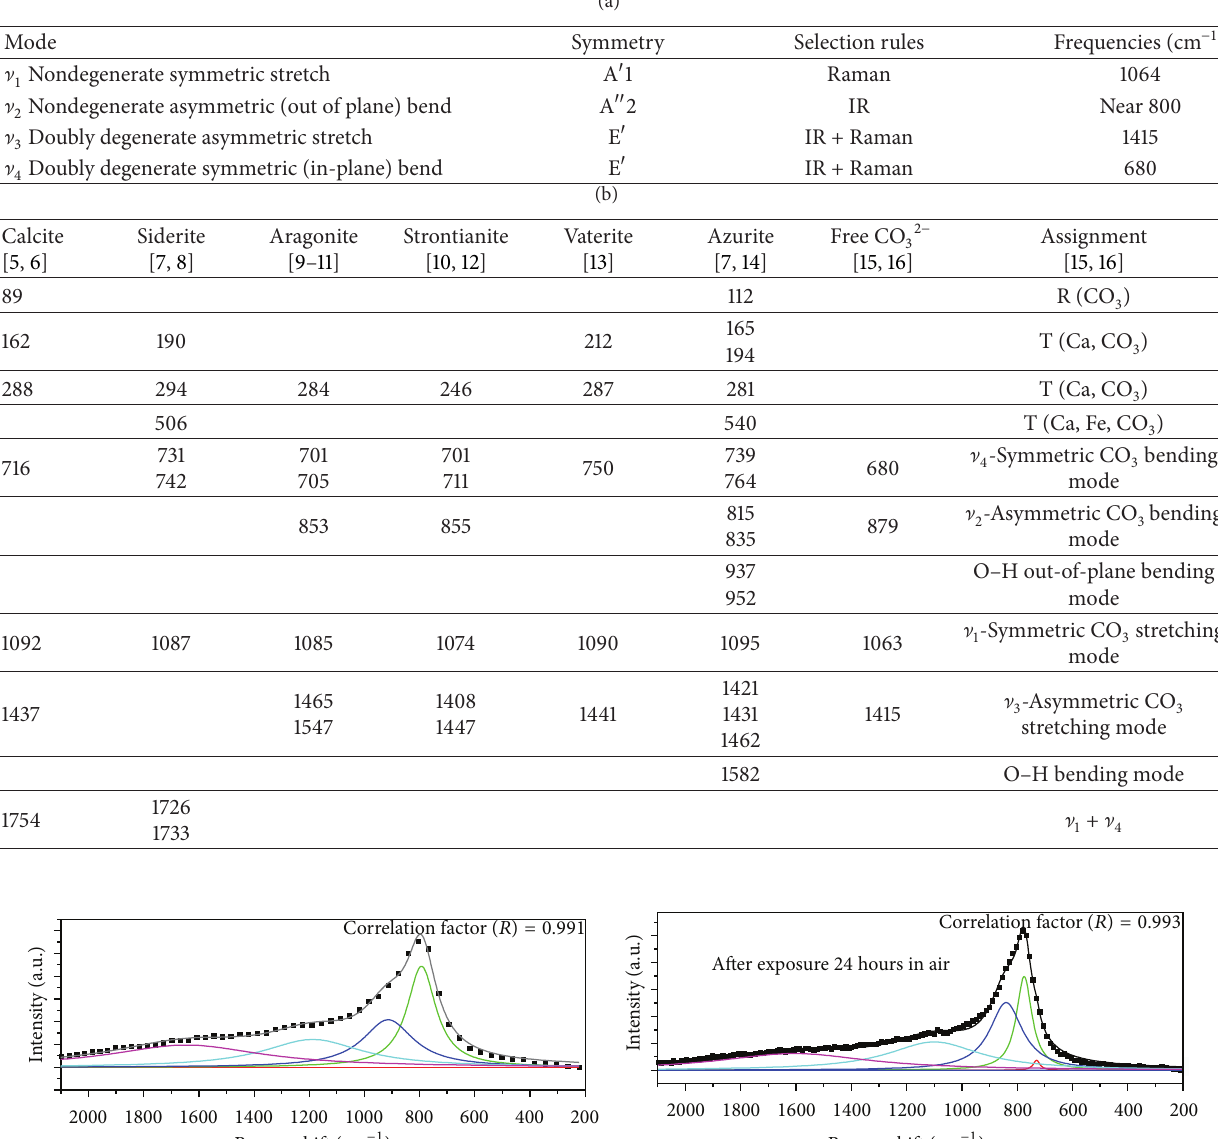
Table 2: (a) Fundamental vibrational modes of the carbonates according to [3, 4]. (b) Raman bands in some carbonates and hydroxyl- carbonates.